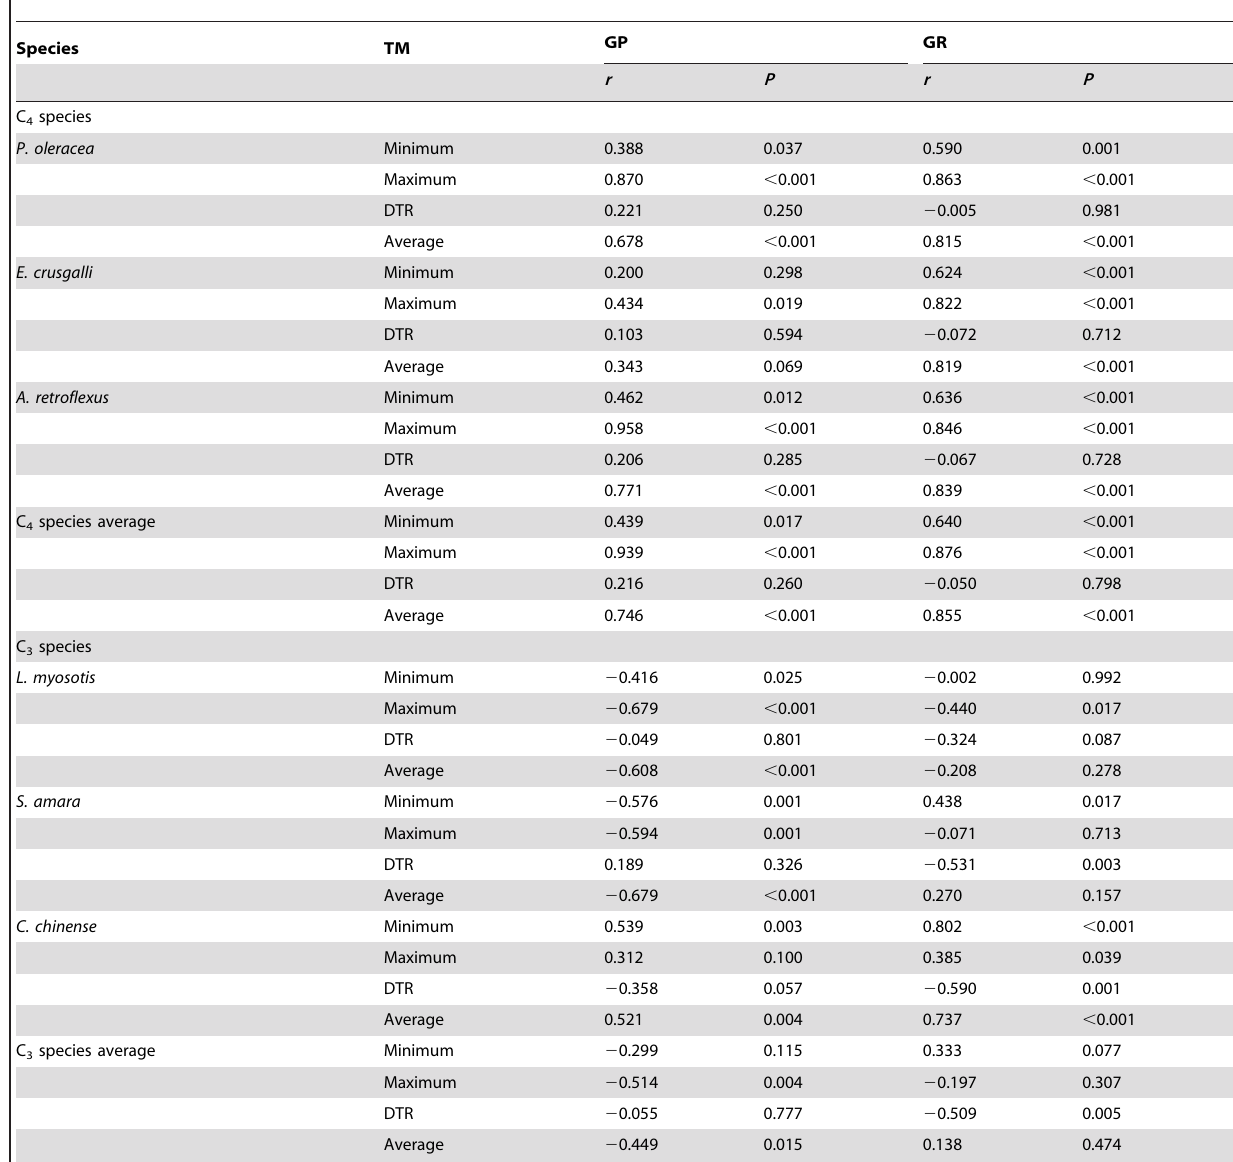
Table 4. Pearson correlation analysis of germination percentage (GP) and germination rate (GR) with temperature metrics (TM, minimum, maximum, average, diurnal temperature range (DTR)) from the four alternating temperature regimes for C 4 and C 3 species ( r , correlation coefficient; P , probability for the